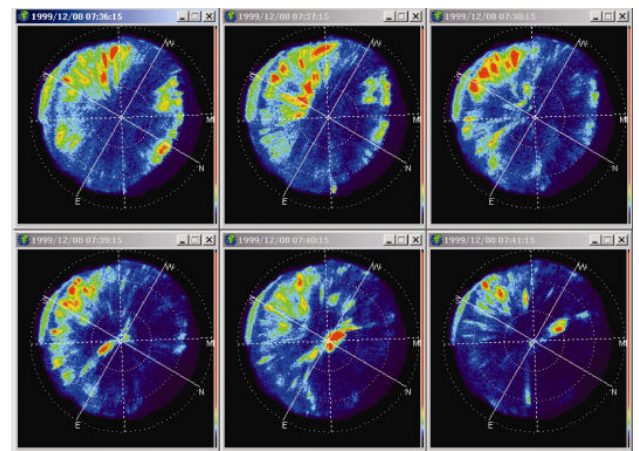
Figure 3 Fig. 3. ASC images at 557.7nm from Ny ˚Alesund, representing the times 07:36:15, 07:37:15, 07:38:15, 07:39:15, 07:40:15, and 07:41:15 UT (sequence order: upper panel from left to right, then lower panel in same order). The reference grid is zenith angle (circles at 30, 60, 90 ◦ ), azimuth angle (straight dashed lines). The MSP scanning meridian (see Fig. 4) is marked north (N) – south (S). The integration time is